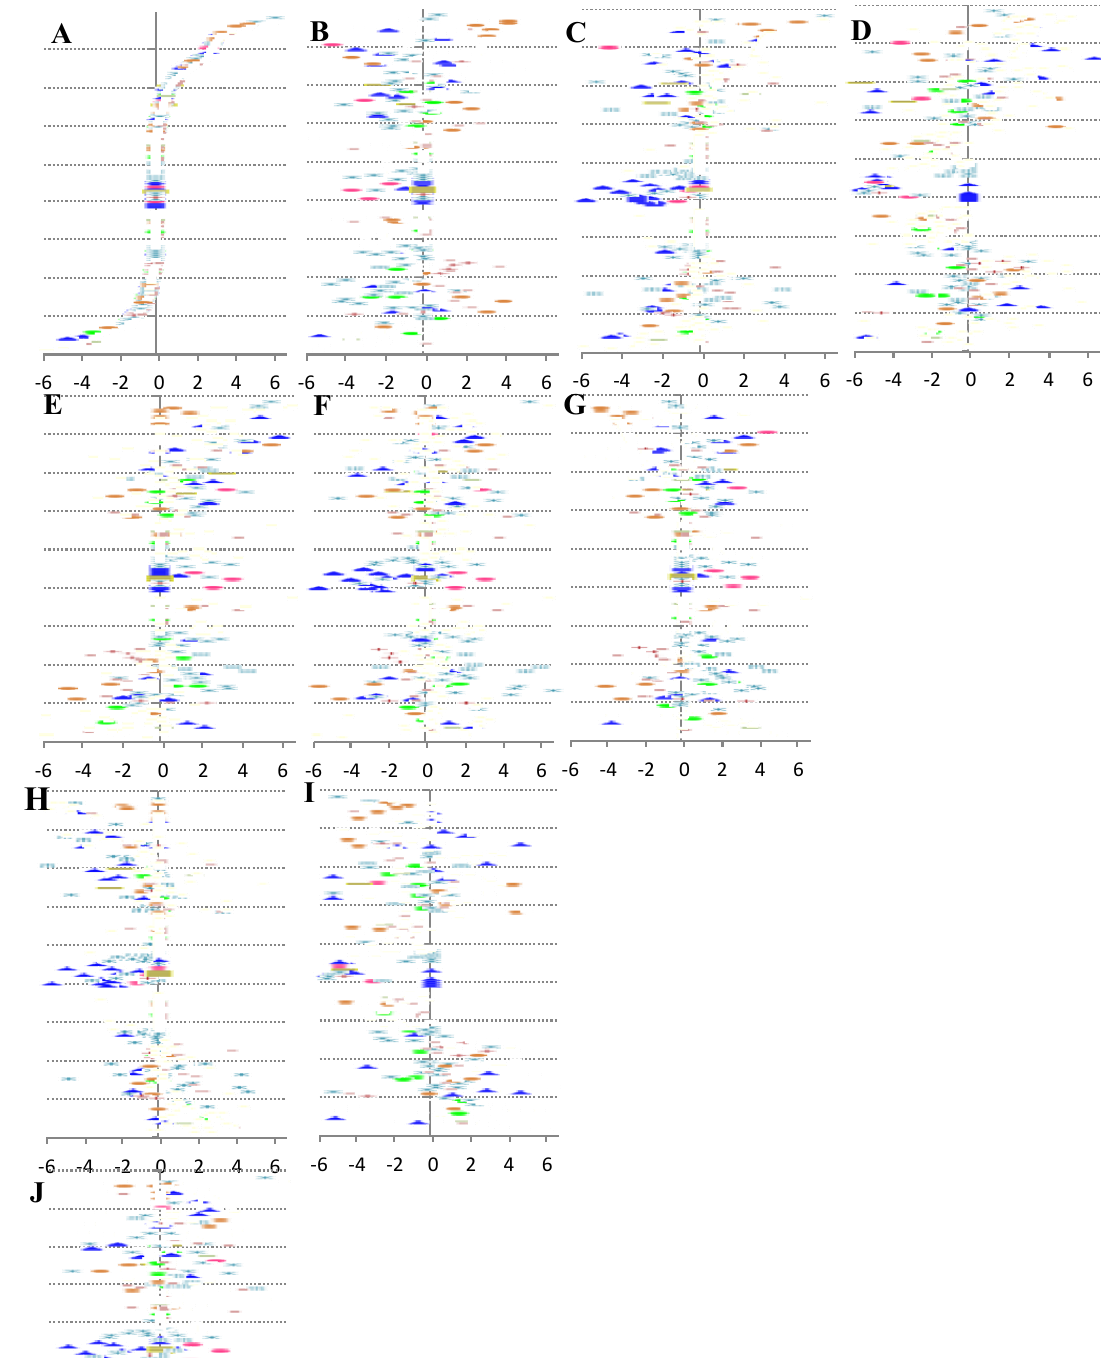
Figure 9. Differential accumulation of 455 metabolites between different pairs of Prunella